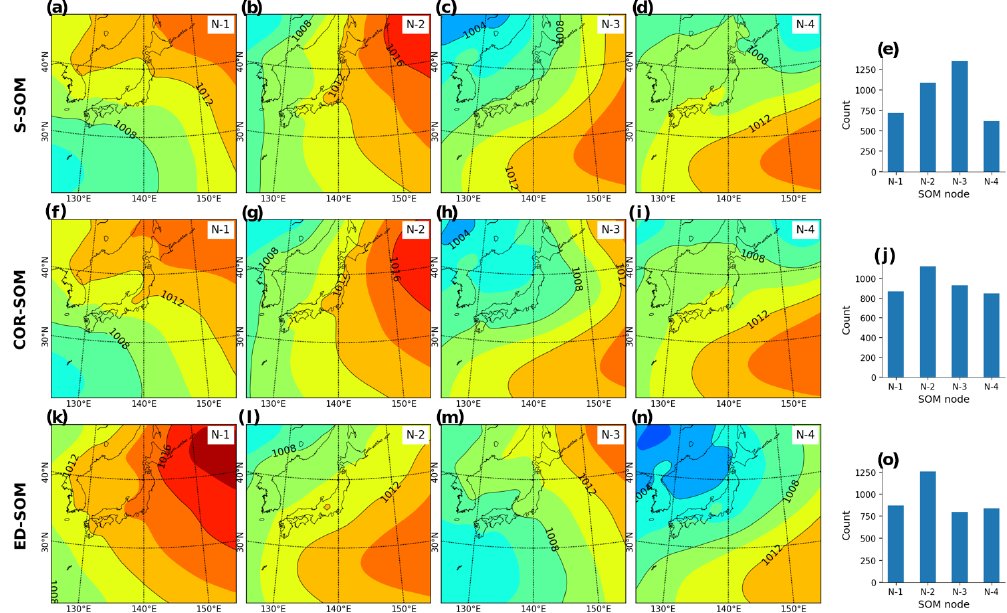
Figure A3. Summer (JJA) MSLP pattern revealed by SOMs. Panels (a) – (d) show S-SOM patterns (with four nodes); panel (e) shows the number of daily MSLPs classified as nodes 1 to 4. Panels (f) – (i) show the same result but for COR-SOM; (k) – (o) for ED-SOM.